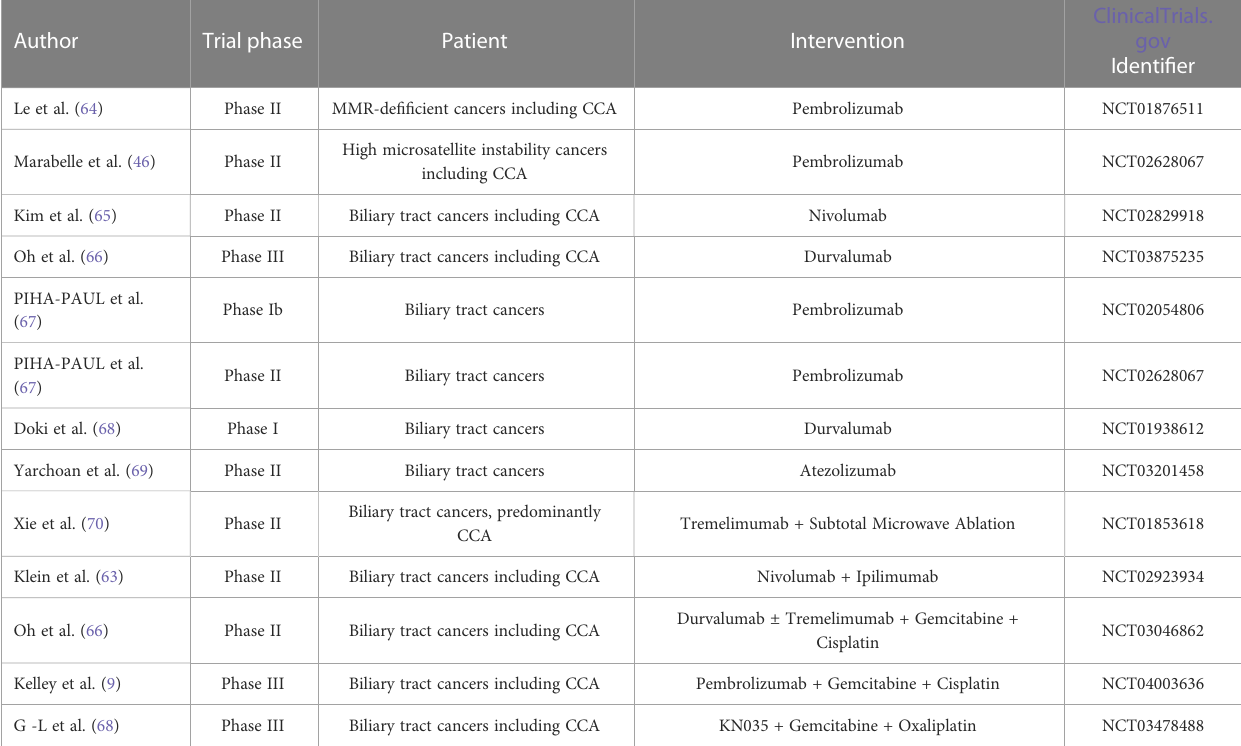
TABLE 1 Clinical trials related to immune checkpoint therapy in